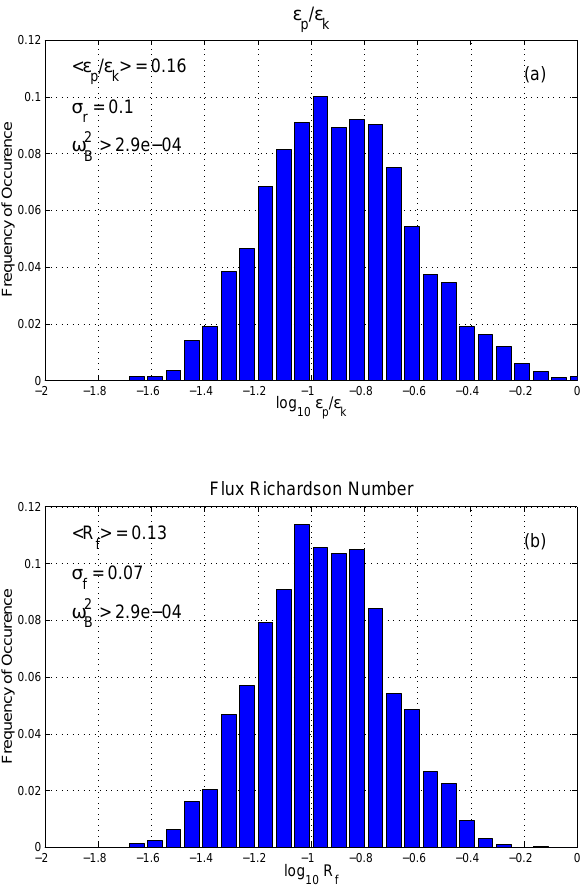
Fig. 5. The frequency of occurrence of the ratio of dissipation rates (a) and the inferred flux Richardson number (b) . From Dole et al.